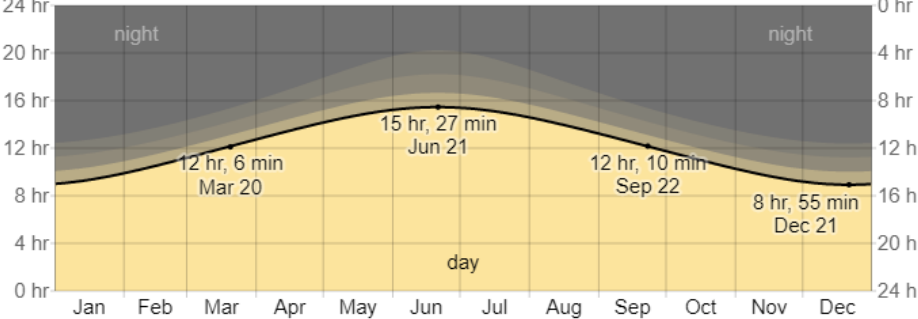
Figure 2. Hours of daylight and twilight in Toronto, Canada [33].